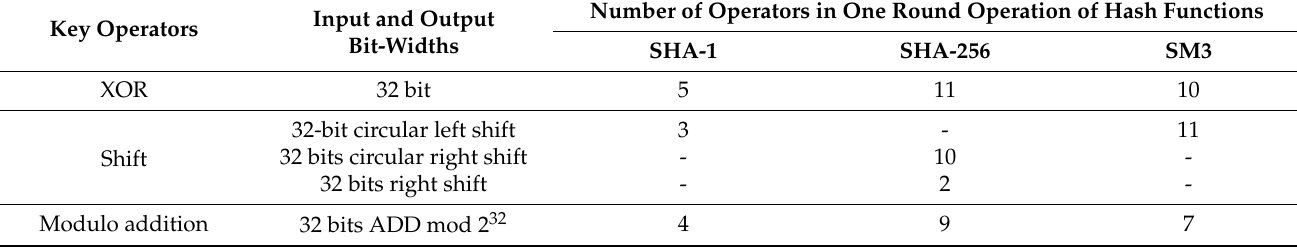
Table 4. Detailed information of key operators in the three major hash